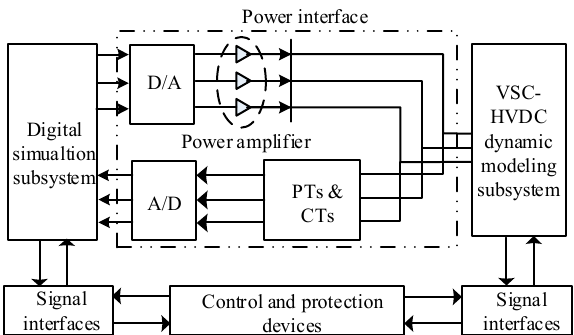
Figure 1. General structure of a digital-physical hybrid simulation (DPHS) system.